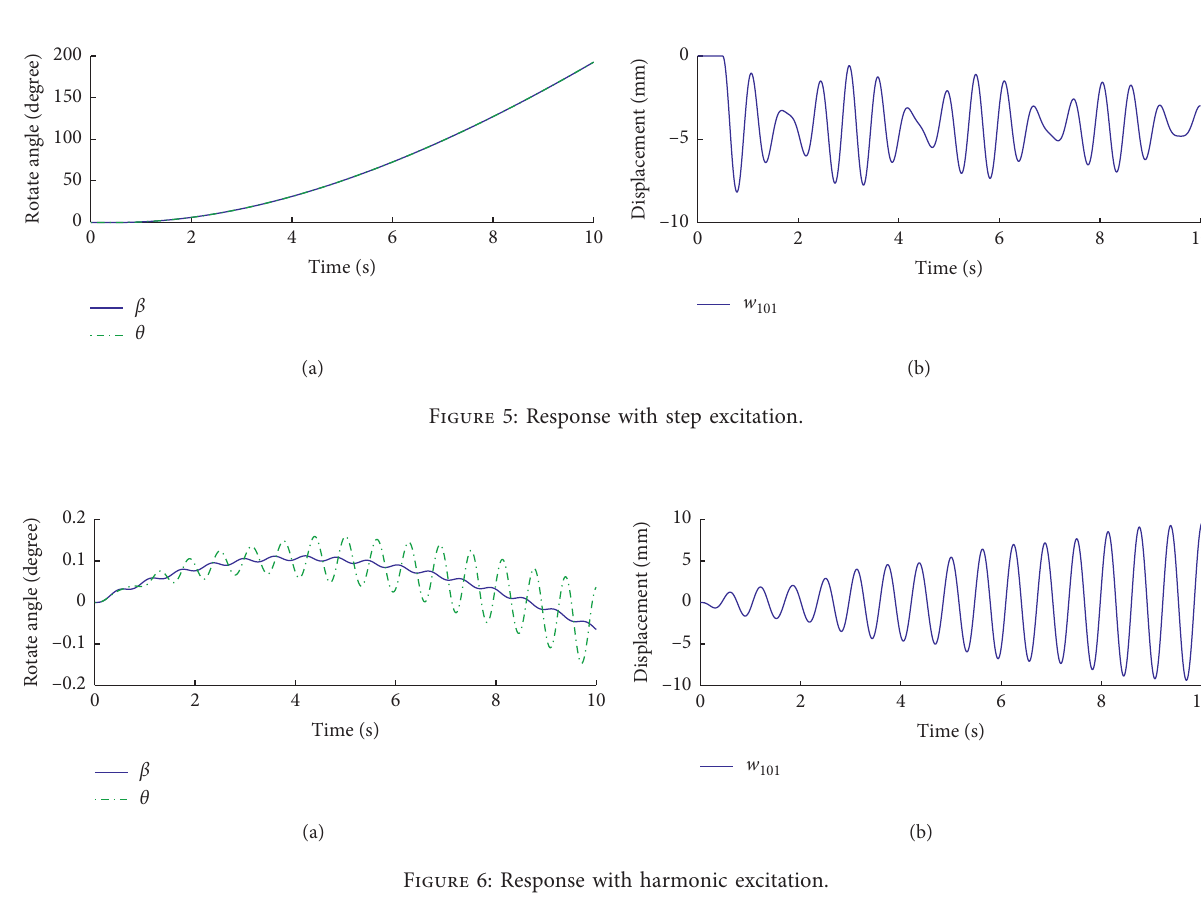
Figure 6: Response with harmonic